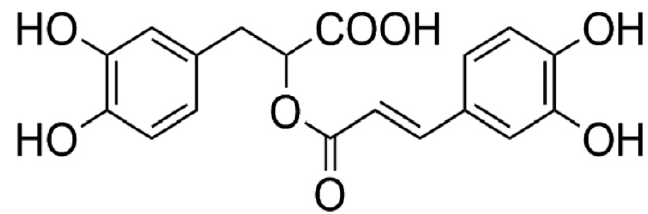
Figure 1. Chemical structure of rosmarinic acid.